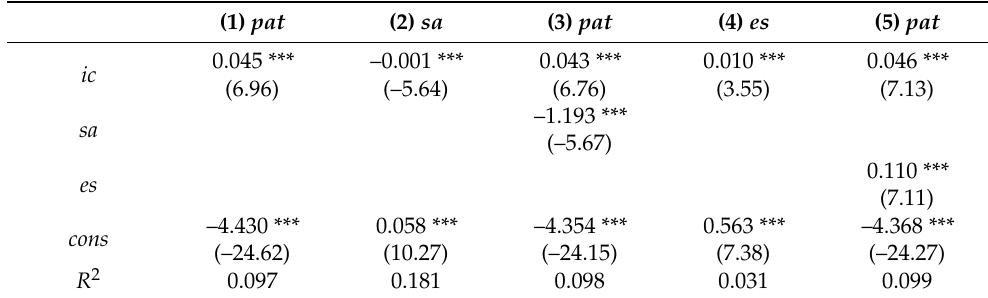
Table 6. Mechanism test results of financing constraints and rationality of green innovation invest-